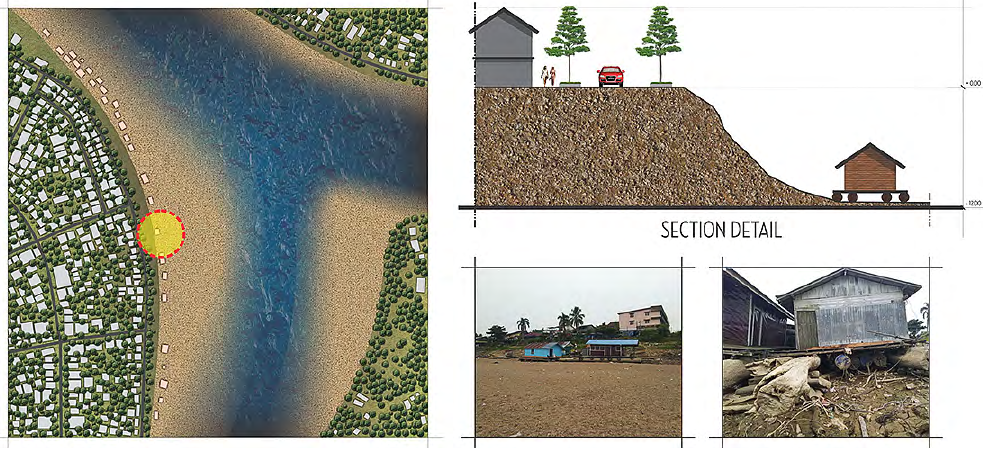
Figure 3. Ebb condition of Melawi River